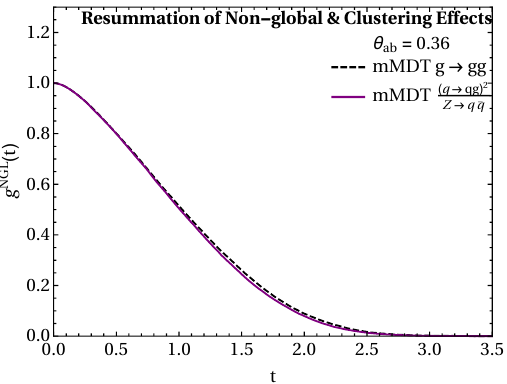
Figure 4 . Testing the large N c (cid:13)avor relations, naively violated due to the C/A clustering history phase-space constraints.